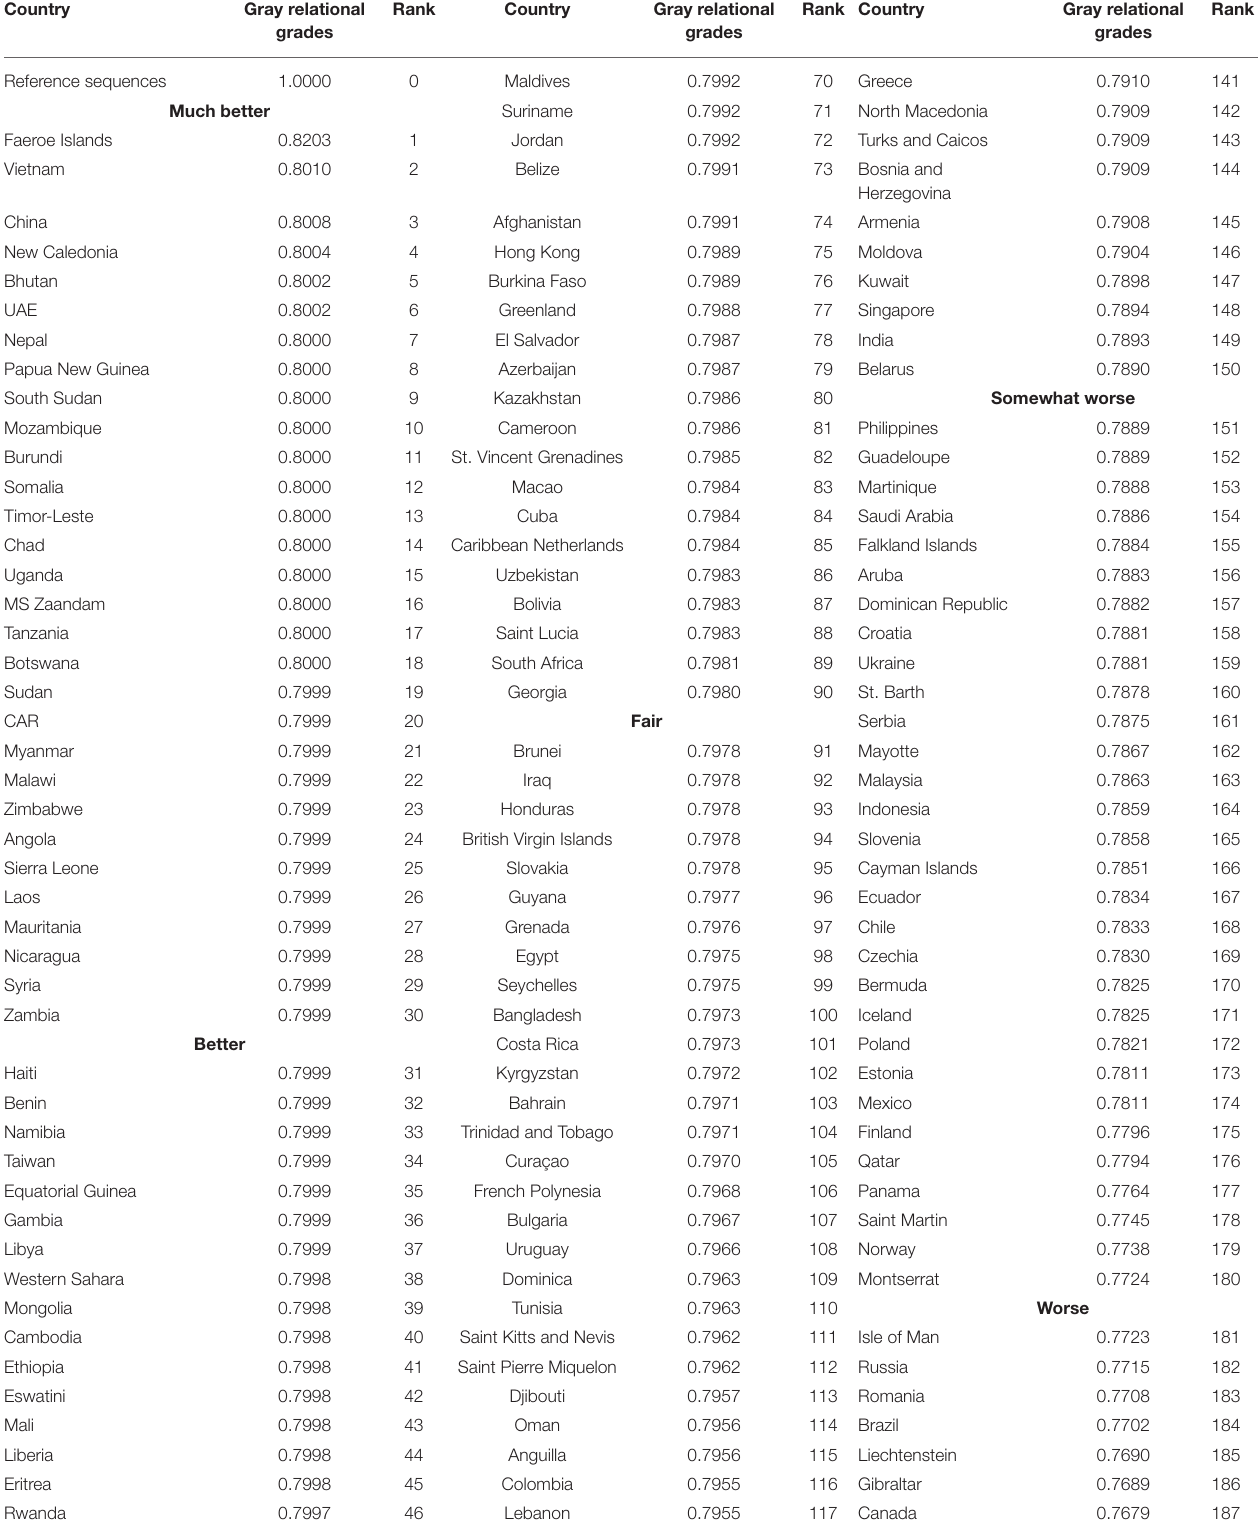
TABLE 9 | Results of gray relational